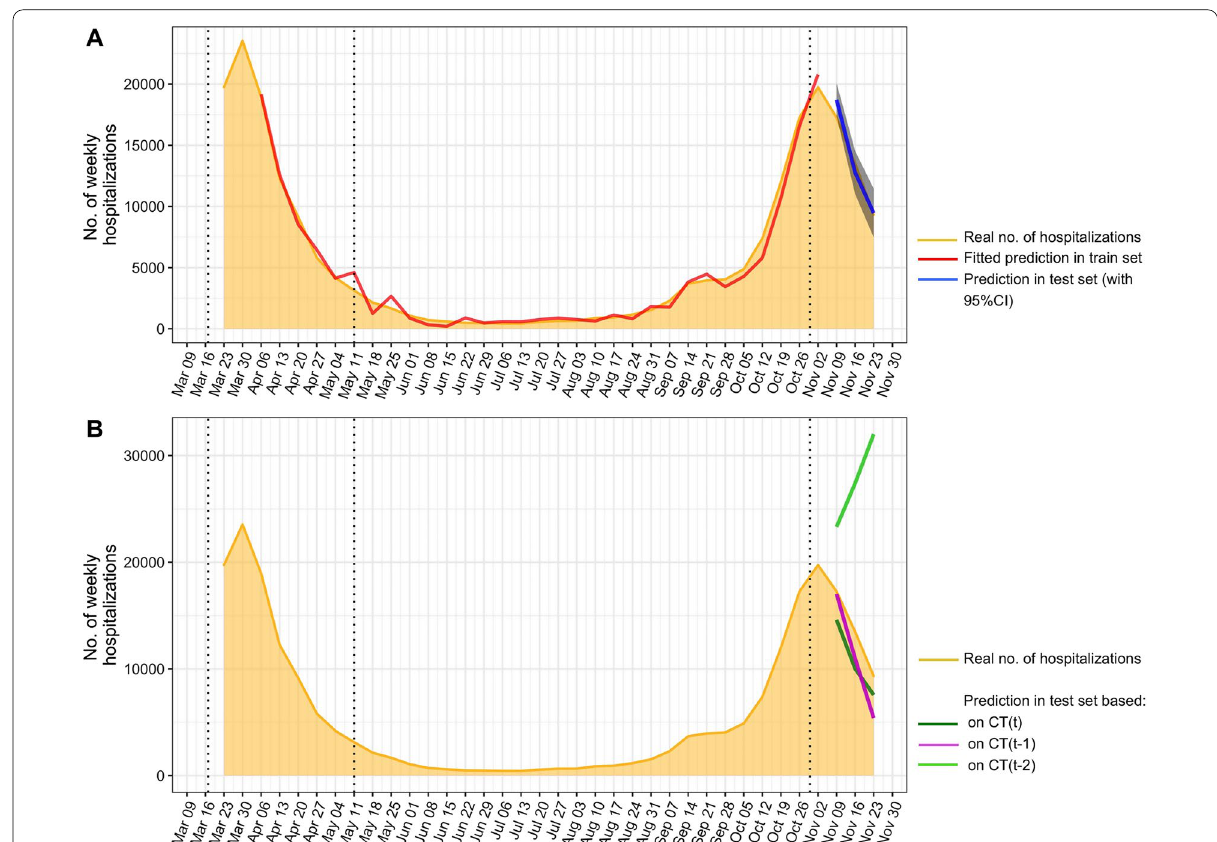
Fig. 5 Predictions of the best model ( a ) and the models based on the number of CT‑scans performed the same week (CT( t )), one week before (CT( t 1)) and two weeks before (CT( t 2)) in the COVID‑19 workflow ( b ). The dotted lines correspond to the beginning and the end of the 1 st − − national lockdown and the beginning of the 2nd national lockdown, respectively. Abbreviations: 95%CI: 95% confidence interval, no.: